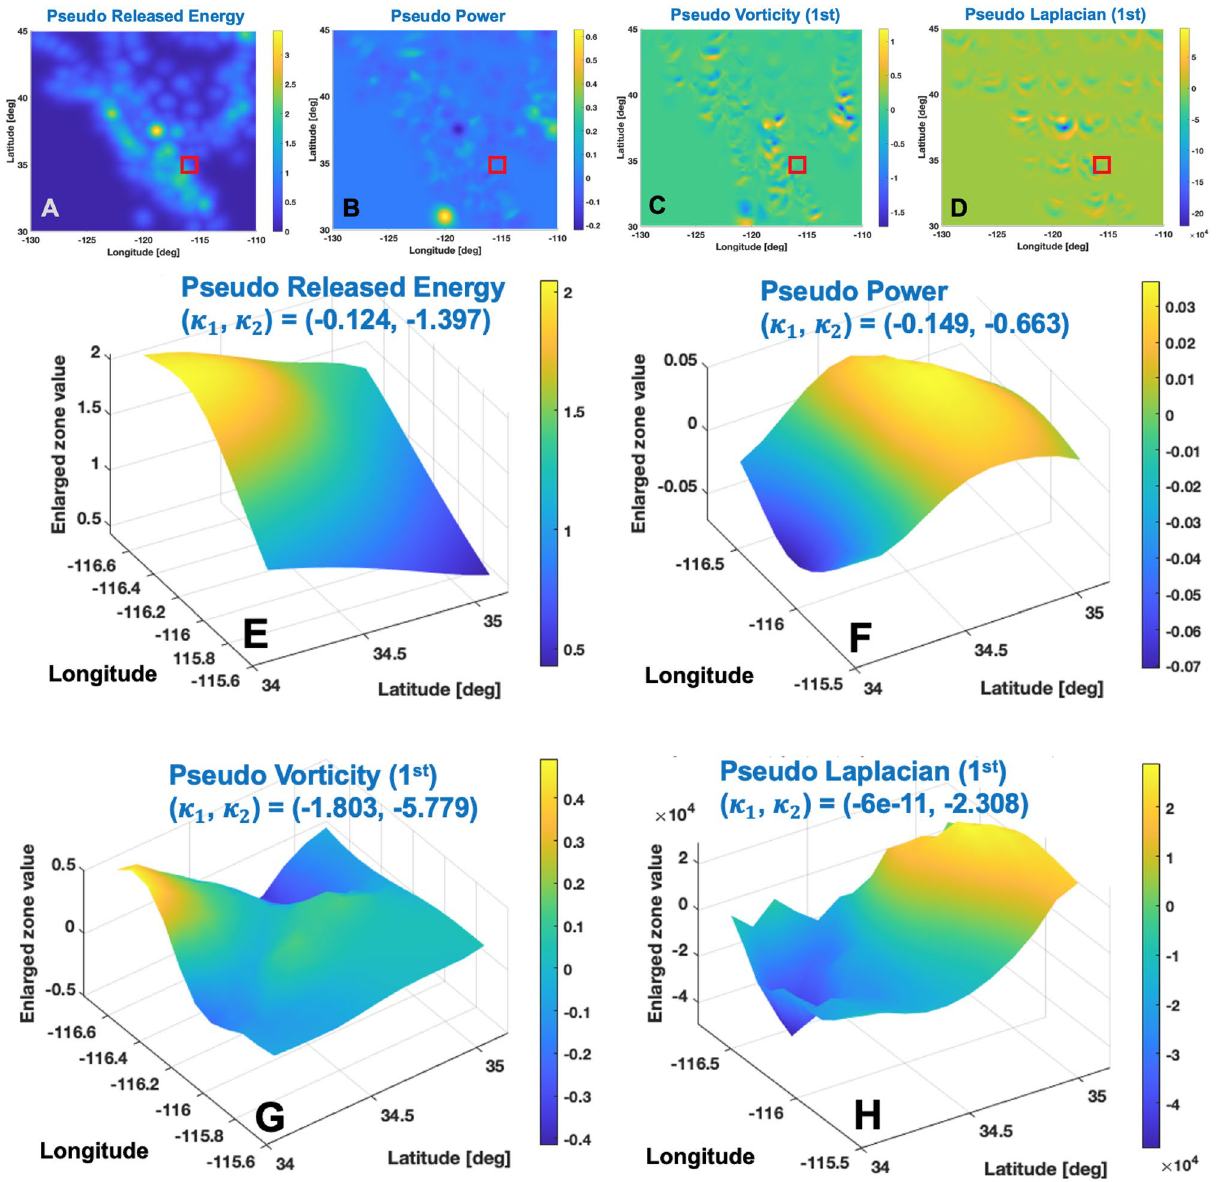
Figure 2. Example plots of pseudo physics quantities generated with 10 years data up to one month before the epoch 10237 (i.e., 1999/10/16): (A–D) The pseudo released energy ( E r ), the pseudo power ( ∂ E r /∂ t ), the first term of pseudo vorticity ω (cid:31) , and the first term of the pseudo Laplacian ∂ 2 E r /∂ (cid:31) 2 . Red box indicate the ± 1 ◦ zone near the peak magnitude ( M w = 7.1 ) covering ( − 116.25 ◦ ± 1 ◦ , 34.65 ◦ ± 1 ◦ ) at depth 12.5 km; (E–H) Enlarged plots of the peak zone (red box in A – D ) and calculated principal Gauss curvatures (κ 1 , κ 2 )